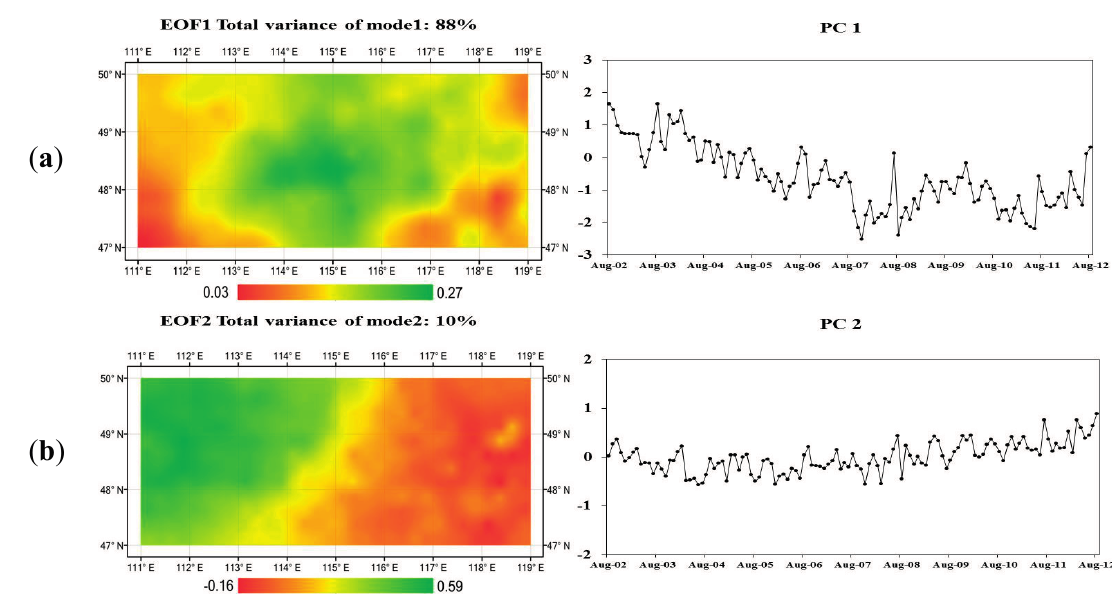
Figure 5. EOF decomposition of TWS changes over the study area. EOF patterns are shown on the left side and corresponding unit-less temporal patterns (PCs) are shown on the right side. ( a ): The first change mode of TWS changes; ( b ): The second change mode of TWS changes.